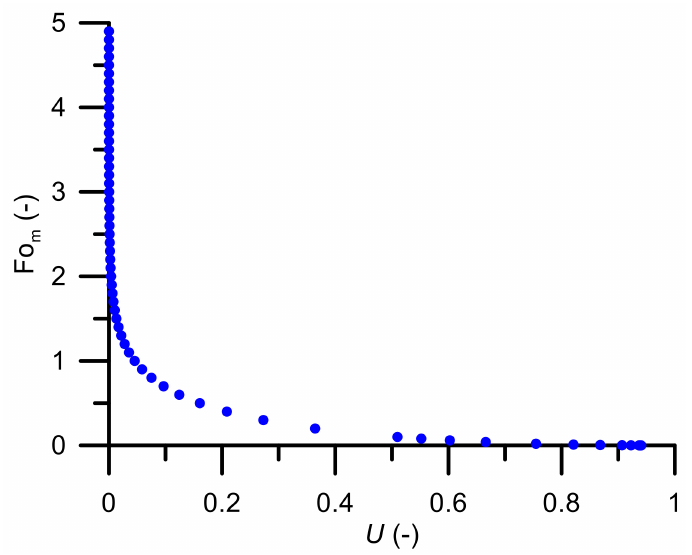
Figure 4. A graph of the value of the Fourier number versus the reduced water content.